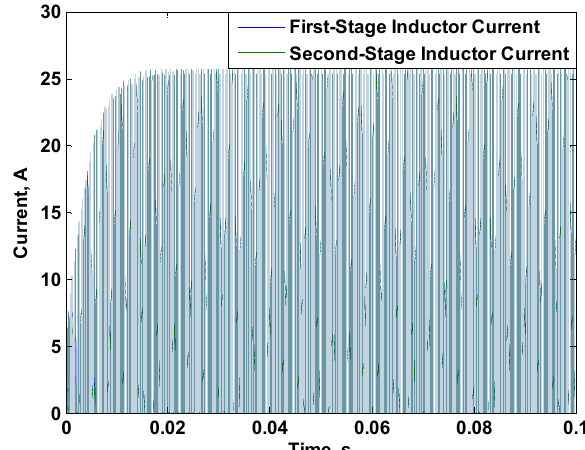
Figure 16. First-stage and second-stage inductor currents at a reference voltage of 100 V.